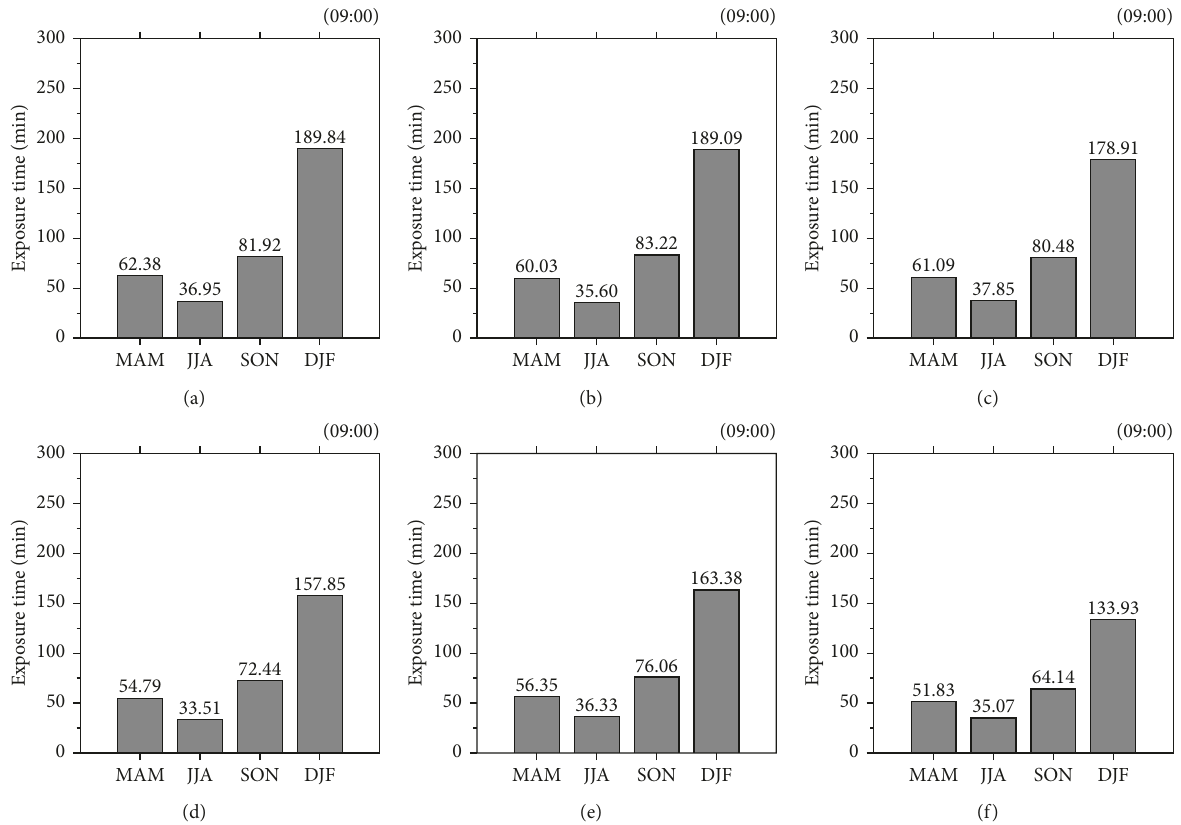
Figure 5: Seasonal average of threshold exposure time for vitamin D synthesis at 6 different stations at 9 a.m. in (a) Seoul, (b) Gangneung, (c) Anmyeondo, (d) Pohang, (e) Mokpo, and (f) Gosan.